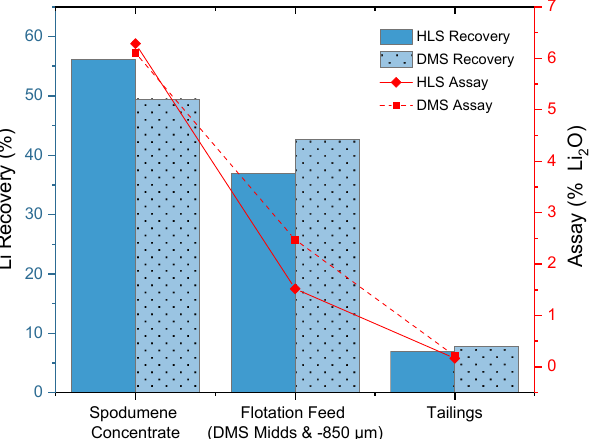
Figure 10. Comparison of heavy liquid separation and dense media separation results.